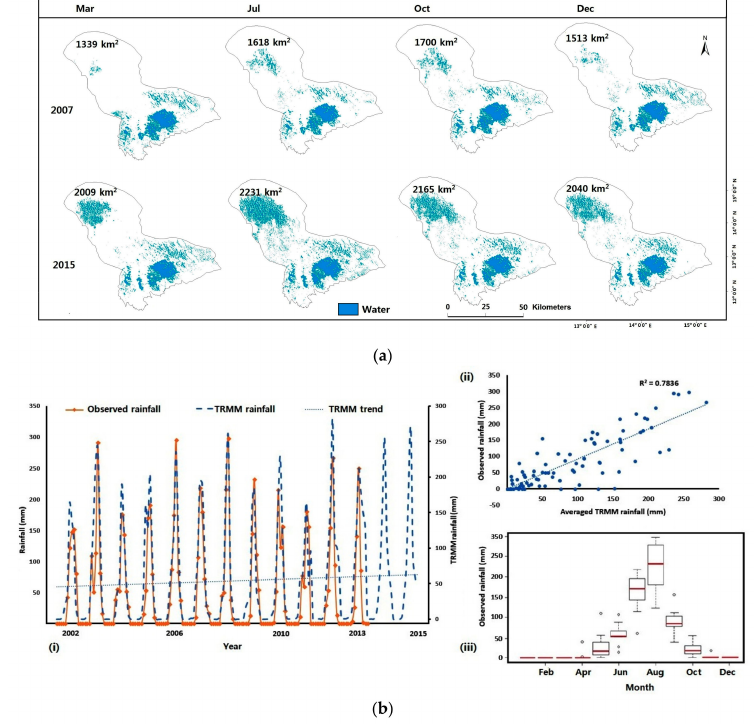
Figure 9. ( a ) Estimated lake surface water area changes for our test years. These years were chosen as representative examples of the 13-year period. ( b ) (i) Monthly rainfall estimates from the LCBC and TRMM 3B42; (ii) Scatter plot comparing their monthly mean; (iii) Boxplot of the observed rainfall